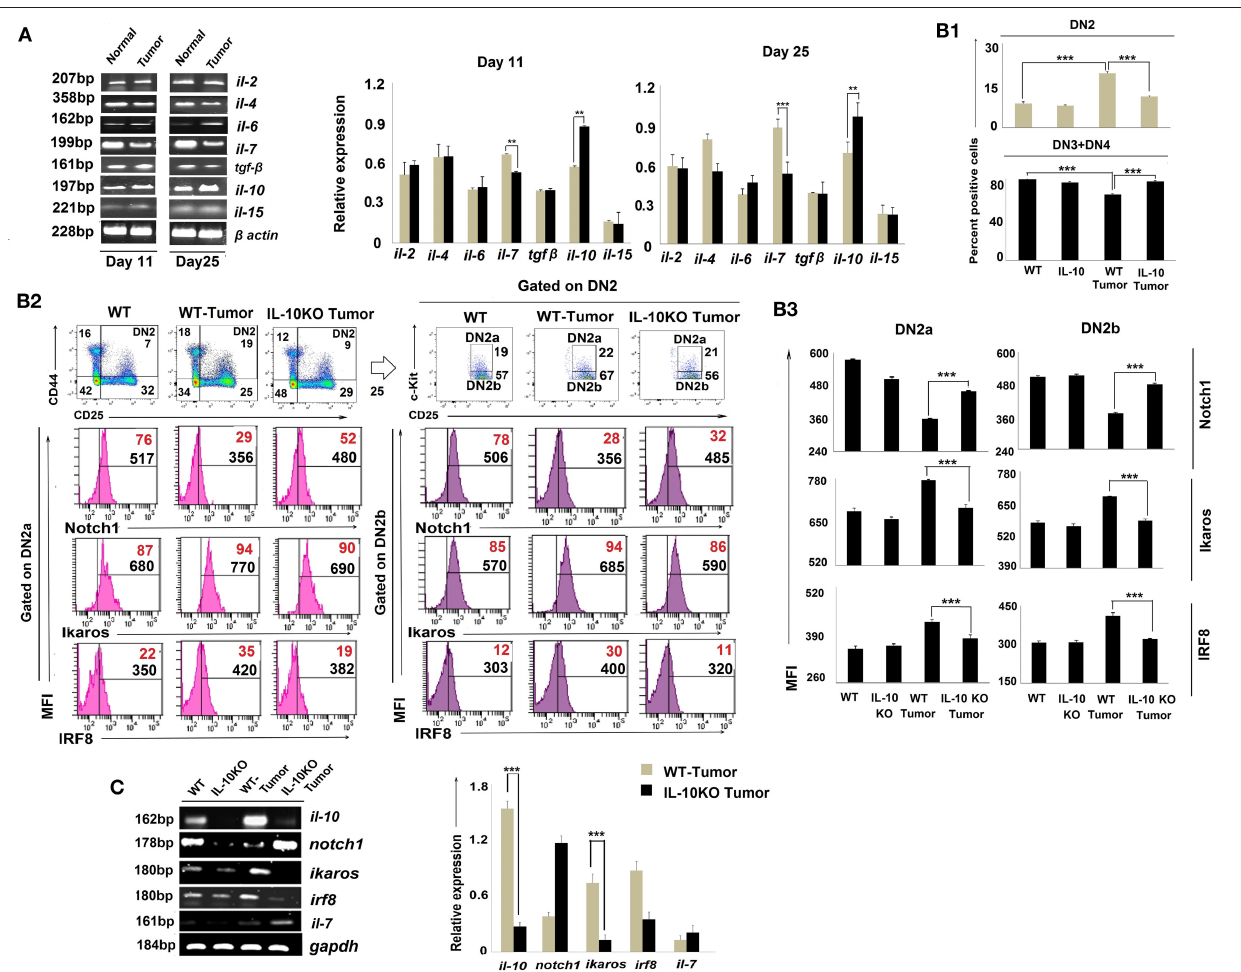
FIGURE 5 | IL-10 promotes tumor-induced early arrest of DN2 pro-T cells by reciprocal regulation of Notch1 and Ikaros signaling. (A) mRNA was isolated from thymi of normal and tumor hosts, and cytokine ( il-2, il-4, il-6, il-7, il-10, il-15 , and tgf β ) profiles were assessed by RT-PCR, keeping β -actin as a loading control. Representative figures of gene expression profile are shown in the left panel and bar diagrammatic representations of mean ± SE of relative expression of above-mentioned cytokines from normal and tumor hosts on days 11 and 25 following tumor inoculation, respectively, are shown in the right panel, n = 3; ** p < 0.01, *** p < 0.001. (B1) Thymic T cells were isolated from non-tumor (wild-type and IL-10 − / − ) and tumor (wild-type and IL-10 − / − ) mice. DN2, DN3, and DN4 cells were stained with CD45, CD4, CD8, CD25, CD44, and c-Kit. Gating strategies are shown in Supplementary Figure 1 . Bar diagrams represent the mean ± SE percentage of DN2 and DN3 + DN4 positive cells from the above-mentioned mice, respectively. (B2) Representative figures of flow cytometric analysis performed with CD45, CD4, CD8, CD44, CD25, c-Kit, Ikaros, IRF8, and Notch1 in thymic T cells from wild-type and IL-10 − / − tumor-bearing mice. Histograms show MFI and positive percentages of cells of DN2a + Notch1 + , DN2a + Ikaros + , DN2a + IRF8 + DN2b + Notch1 + , DN2b + Ikaros + , and DN2b + IRF8 + . (B3) Bar diagrams showing mean ± SE of MFI values of Notch1 + , Ikaros + , and IRF8 + within DN2a and DN2b cells, respectively, from the mice mentioned in B2. (C) Cytokine and transcription factor profiles were assessed in sorted DN2 cells from non-tumor (wild-type and IL-10 − / − ) and tumor (wild-type and IL-10 − / − ) mice by analyzing il-10, notch1, ikaros, irf8 , and il-7 gene expressions by RT-PCR, keeping gapdh as a loading control. Representative figures along with bar diagram show mean ± SE of different gene expressions from the above-mentioned mice. n = 4 in each group; p -values are mentioned in